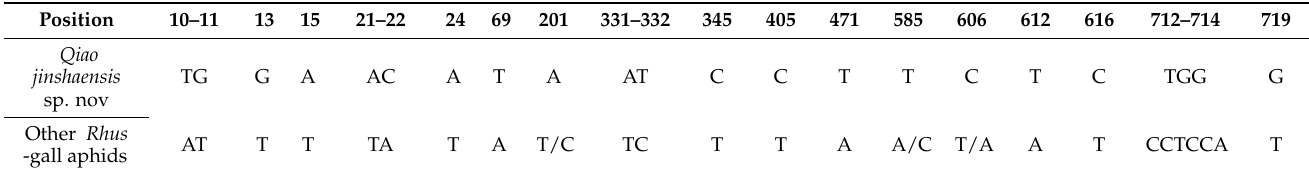
Table 2. Simple and compound diagnostic characters of Qiao jinshaensis sp. nov. for COI locus when compared with other Rhus -gall aphids.